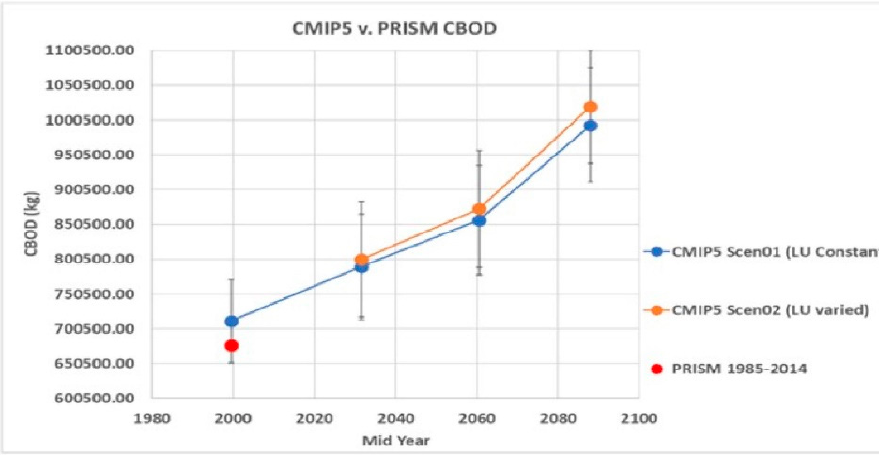
Figure 10. PRISM vs. average of 20 CMIP5 GCMs CBOD (2018–2100).